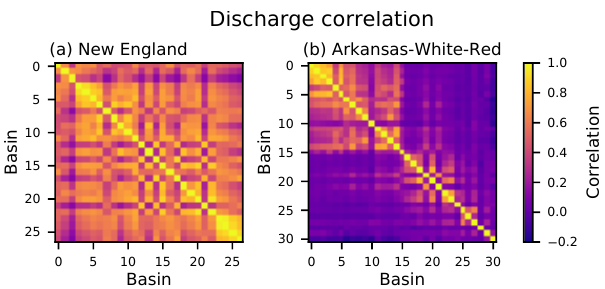
Figure 12. Correlation matrices of the observed discharge of all basins in (a) the New England region and (b) Arkansas-White-Red region. The basins for both subplots are ordered by longitude from east to west.